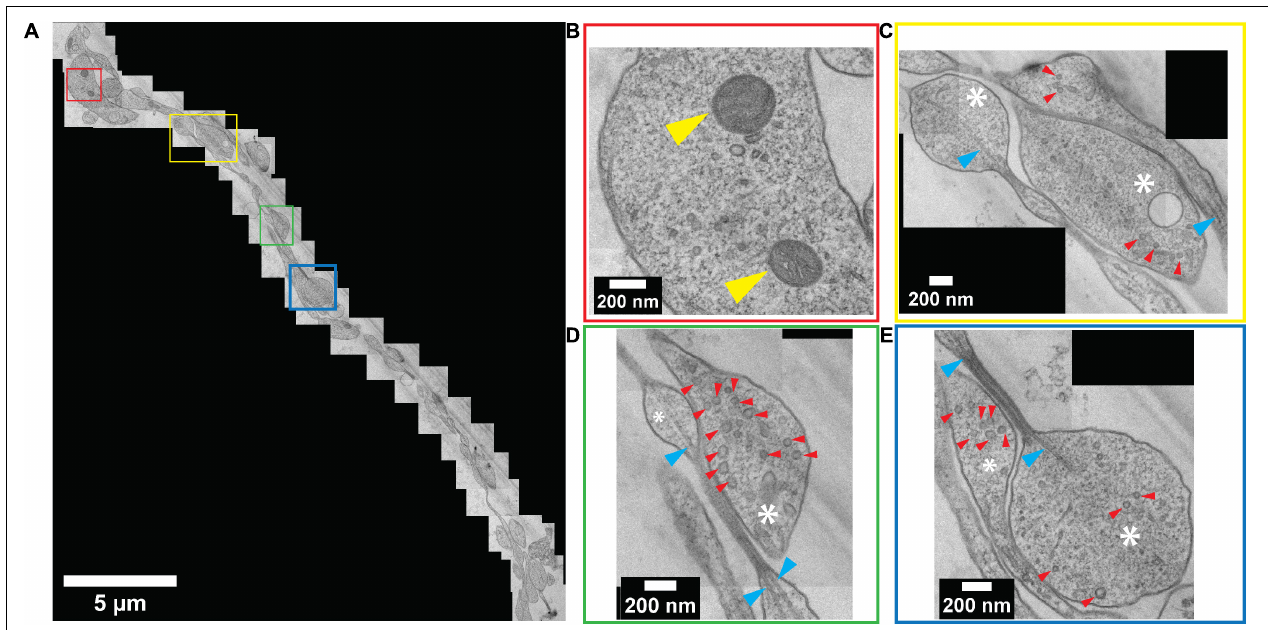
FIGURE 6 | Ultrastructural analysis of resin-embedded embryonic striatal neuron obtained by serial sectioning – TEM. (A) A set of TEM micrographs of neurites embedded in a single channel. (B–E) Enlarged images of boxes outlined in (A) with corresponding colors. Yellow arrowhead, mitochondria; white asterisk, axonal bouton; red arrowhead, synaptic vesicle; blue arrowhead,